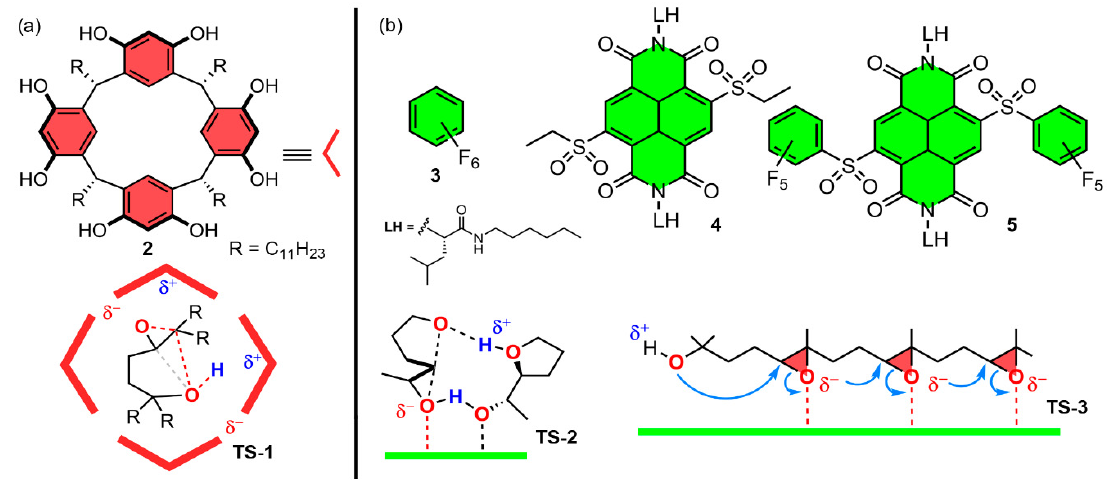
Figure 5. Schematic representation of several catalysts including ( a ) π -basic and ( b ) π -acid surfaces. The plausible transition states including cation– π interactions in confined space of π -basic capsules (TS-1) and anion– π interactions in the cascade cyclization of a tetraepoxide (TS-2 and TS-3) are also included.